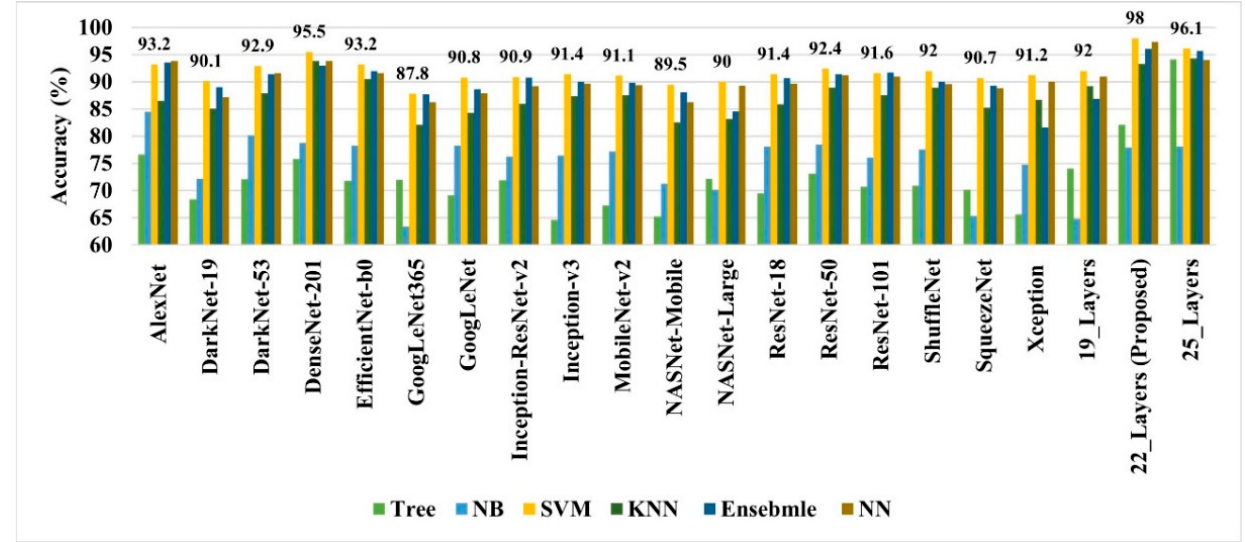
Figure 4. The performance comparison of various deep-feature-trained classical classifier models.